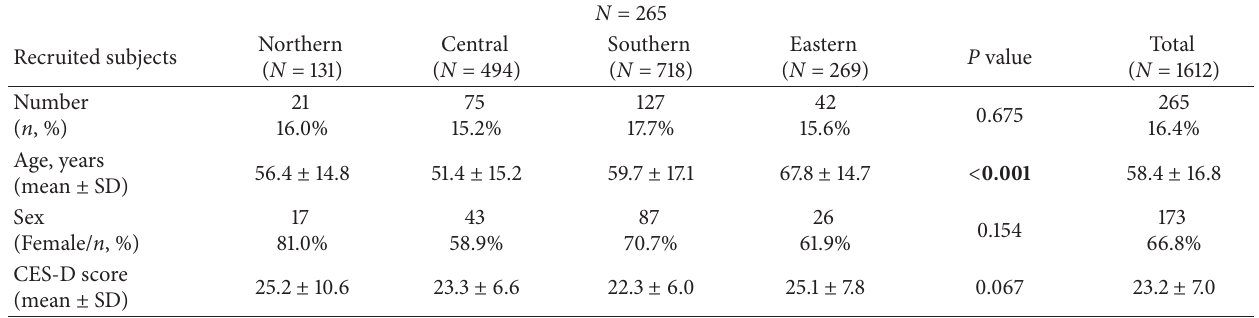
Table 3: Demographic characteristic of participants suspected depression ∗ among all recruited participants.